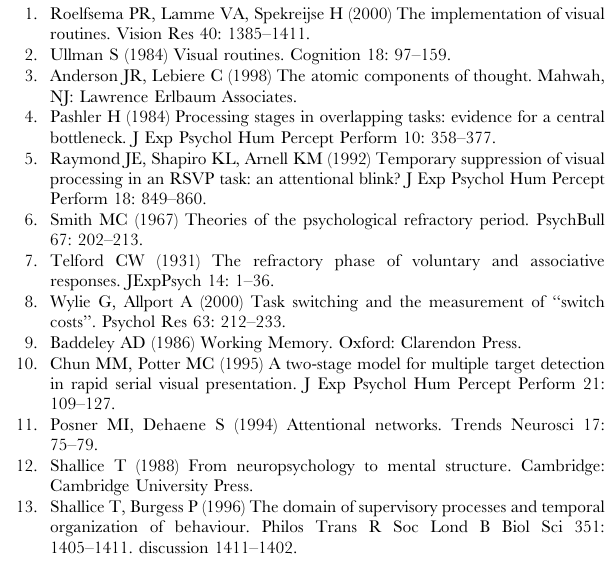
Table S1 Results of the ANOVAs of the interference simula- tions. Each column corresponds to a different ANOVA. Each line represents a different effect: task manipulation, SOA, and their interaction. The top row indicates the identity of the variable under analysis and the second row indicates the type of manipulation (i.e., Notation 1 corresponds to a perceptual manipulation of the first task). Red indicates a significant